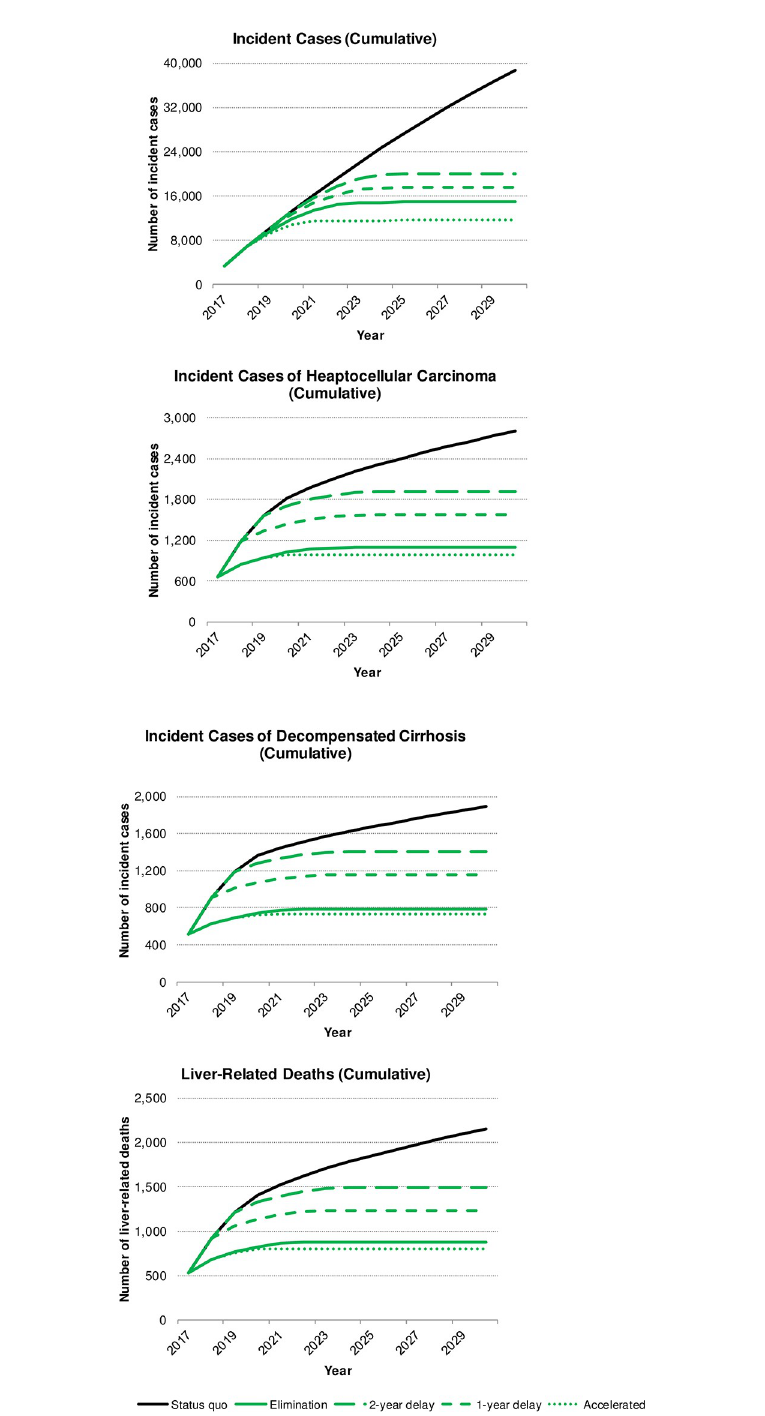
Fig 1. Change in cumulative incident cases of HCV, hepatocellular carcinoma, decompensated cirrhosis and total liver-related deaths, by scenario, 2017–2030.